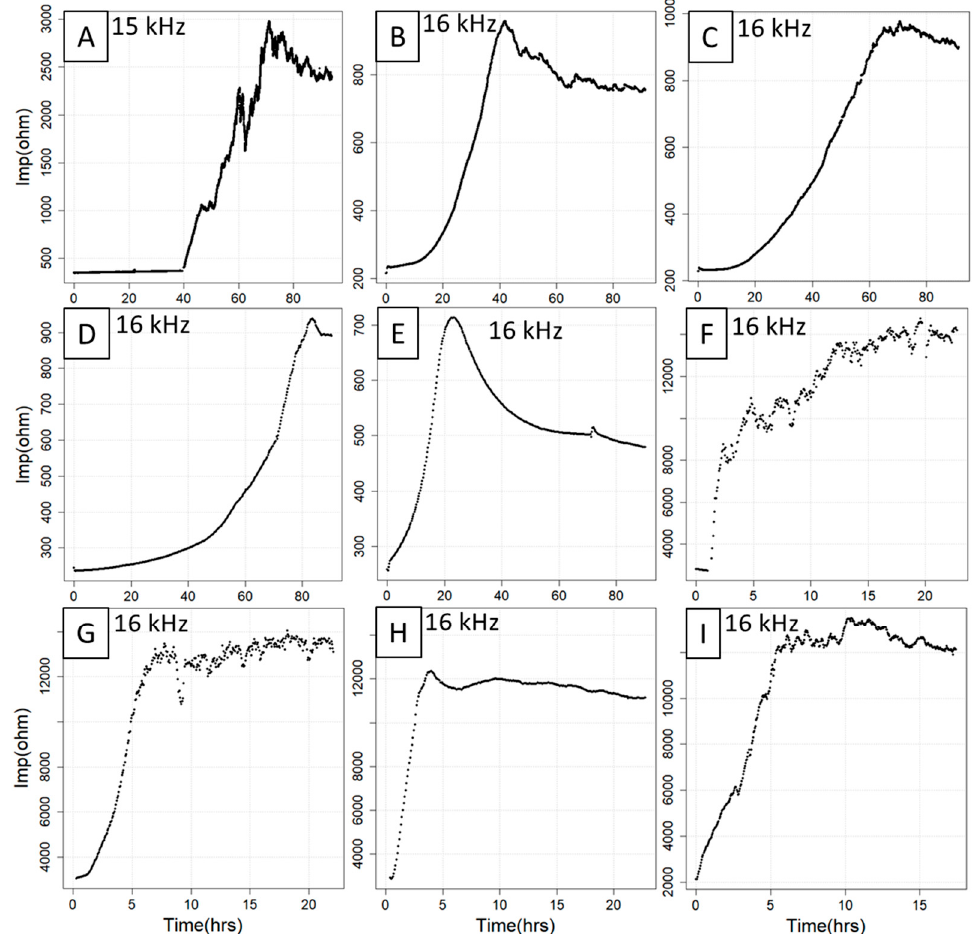
Figure 1. Compilation of nine ECIS curves with different features and trajectories. The curves were obtained from seven experiments involving IPEC-J2 ( A ), CACO2 ( B , C ), C2BBe1 ( D , E ), HUVEC ( F , G ), MDCK cell lines ( H ) and an unknown cell line ( I ) under different treatment regimes. Note that the curves vary substantially with respect to baseline length ( A , B , E ), curve smoothness ( A , E , F ), slope ( C , E , F ) and plateau length and linearity ( D , E , G – I ). hrs = hours, Imp = impedance.